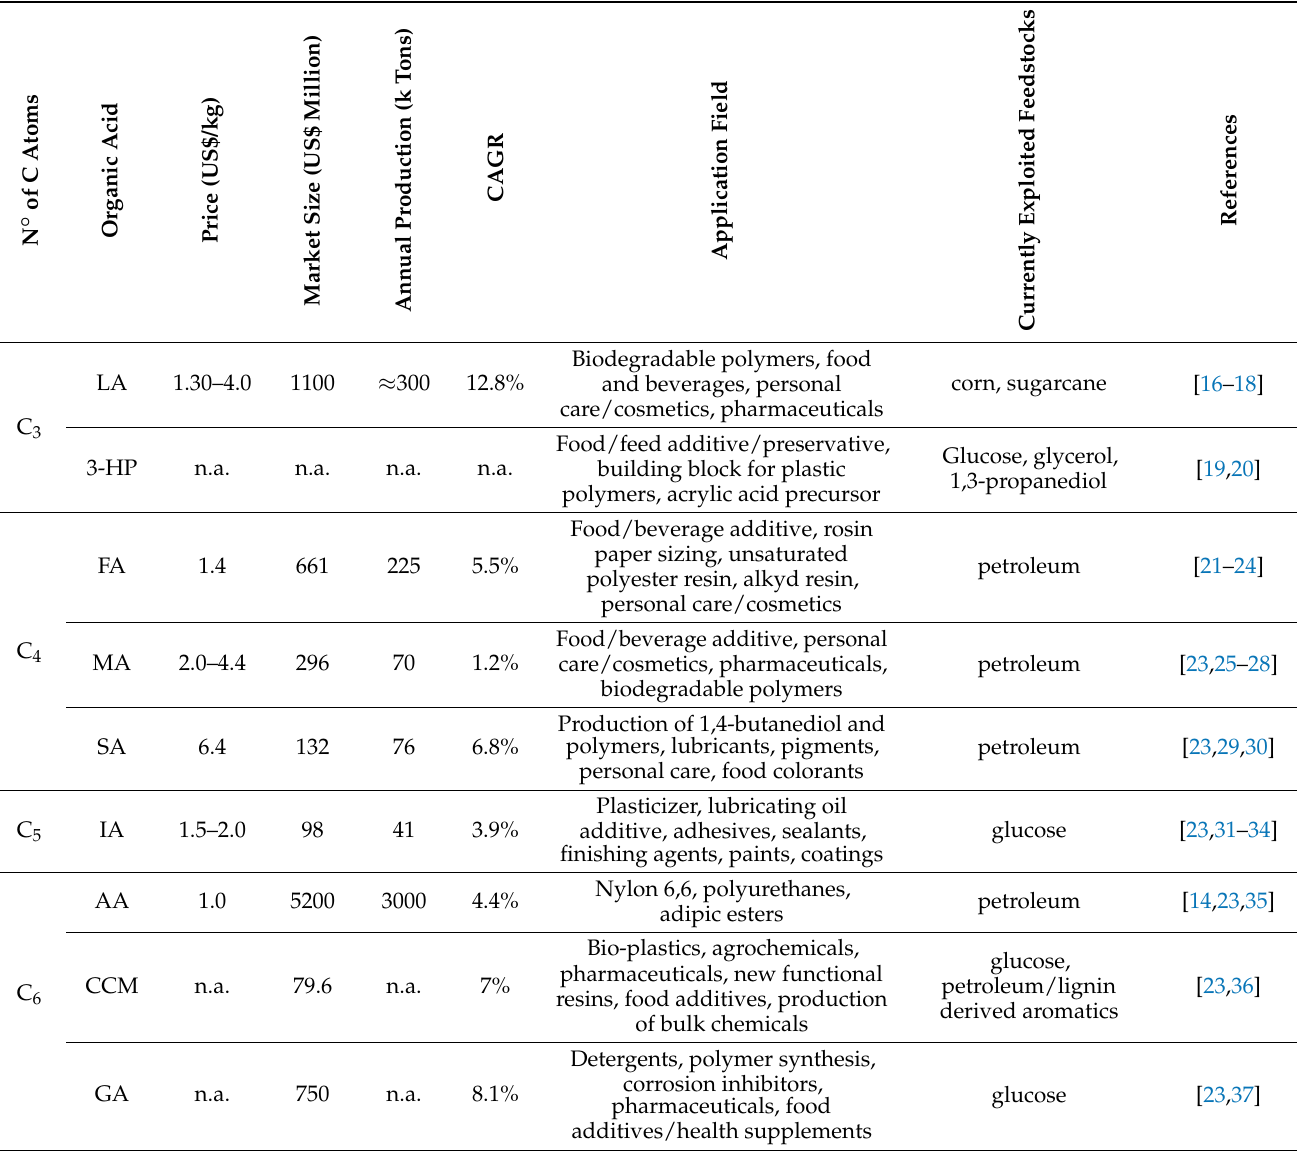
Table 1. Most recent estimation of economic parameters, production feedstocks, and applications of some top value organic acids. 3-HP, 3-hydroxypropionic acid; AA, adipic acid; CAGR, compound annual growth rate; CCM, cis , cis -muconic acid; FA, fumaric acid; GA, glucaric acid; IA, itaconic acid; LA, lactic acid; MA, malic acid; n.a., not available; SA, succinic acid.